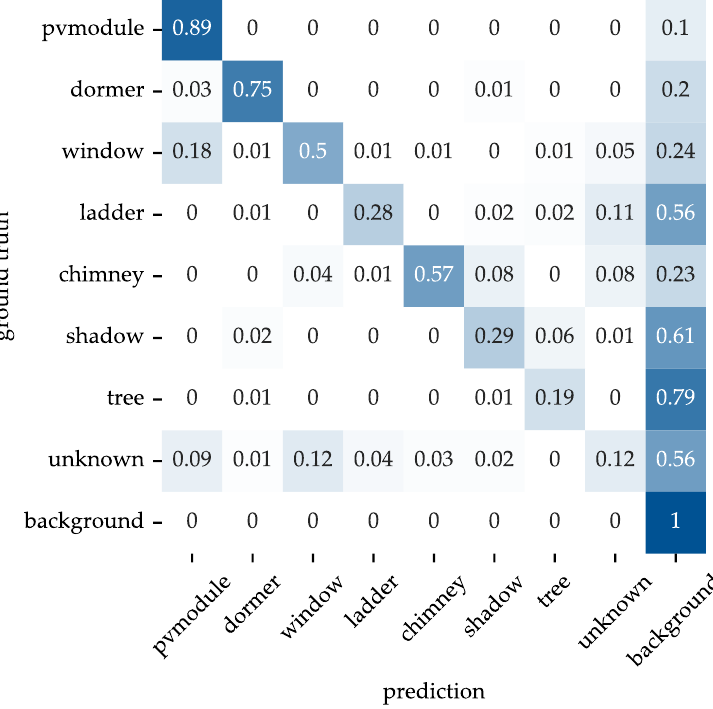
Figure 8. Micro-averaged confusion matrix of the U-Net’s predictions on the test dataset. Annotations were rounded to two digits. Hence, the row’s sum can be unequal to 1. Prediction Examples : Figure 9 Error! Reference source not found. depicts six images with ground truth and prediction. From left to right, the images resemble the top two, median two, and bottom two predictions on the test set with respect to the network’s mean IoU.